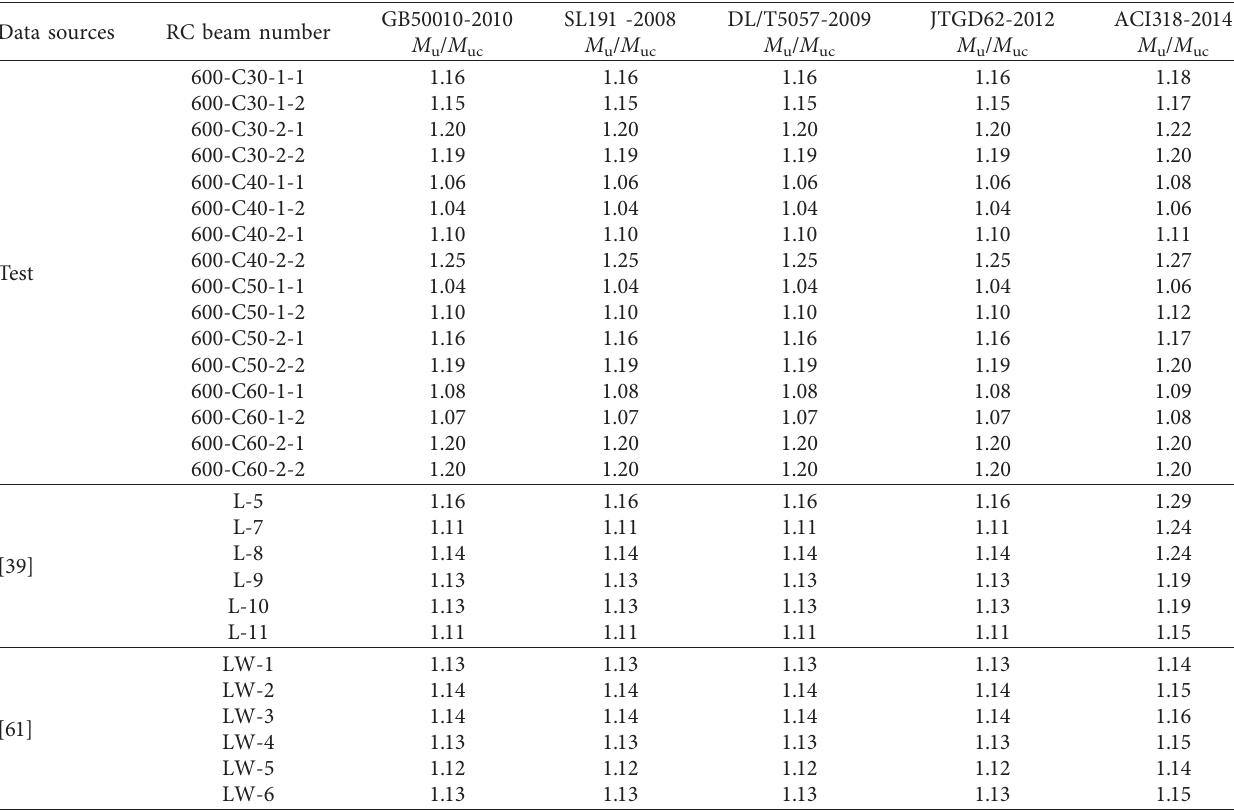
u with M uc calculated by different codes for beams with 600MPa steel